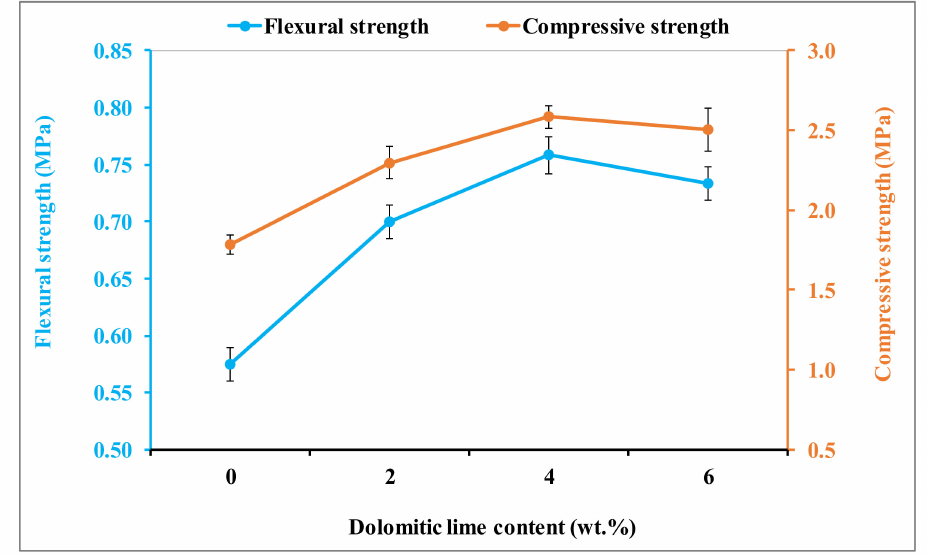
Figure 13. Flexural and compressive strengths of earth renders samples amended with dolomitic